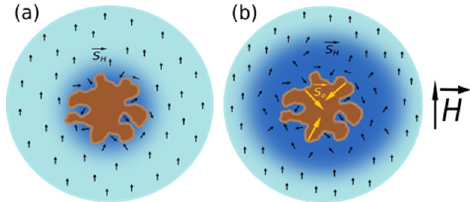
Figure 36. ( a ) Schematic view of the shortening of proton spin relaxation in water (blue regions) nearby a NP (brown spot) without unpaired electron spins; ( b ) the same scheme for the NP with numerous unpaired electron spins centers on the NP surface. Black and yellow arrows correspond to the proton and electron spins, respectively. (Reprinted from Reference [96] by permission from John Wiley and Sons © 2018).